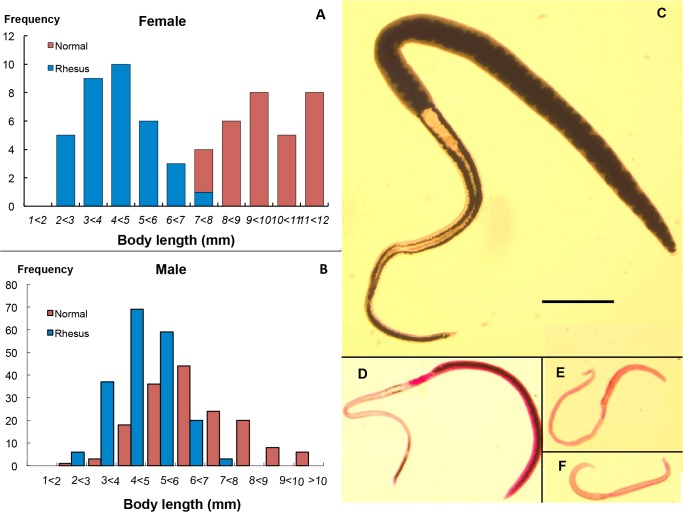
Females are more susceptible to immunological pressure than males in rhesus macaques.The body lengths of females (A) and males (B) from rhesus macaques, were shorter than their equivalents from rabbits, but the two male populations overlapped considerably (B) whilst the females did not (A). The detailed difference in females from the two hosts, a mature female from a rabbit (C) and three from rhesus macaques (D to F) all to scale (bar = 1mm), are compared. (C) The rabbit worm has black hemozoin pigment present along the whole length of the body. Females from monkeys were smaller and showed different levels of pigment in the gut: (D), Black group were full of pigment from ovary to tail, plus traces in the anterior; (E), Intermediate group had incomplete pigment only in the posterior region; (F), White group had virtually no pigment anywhere.